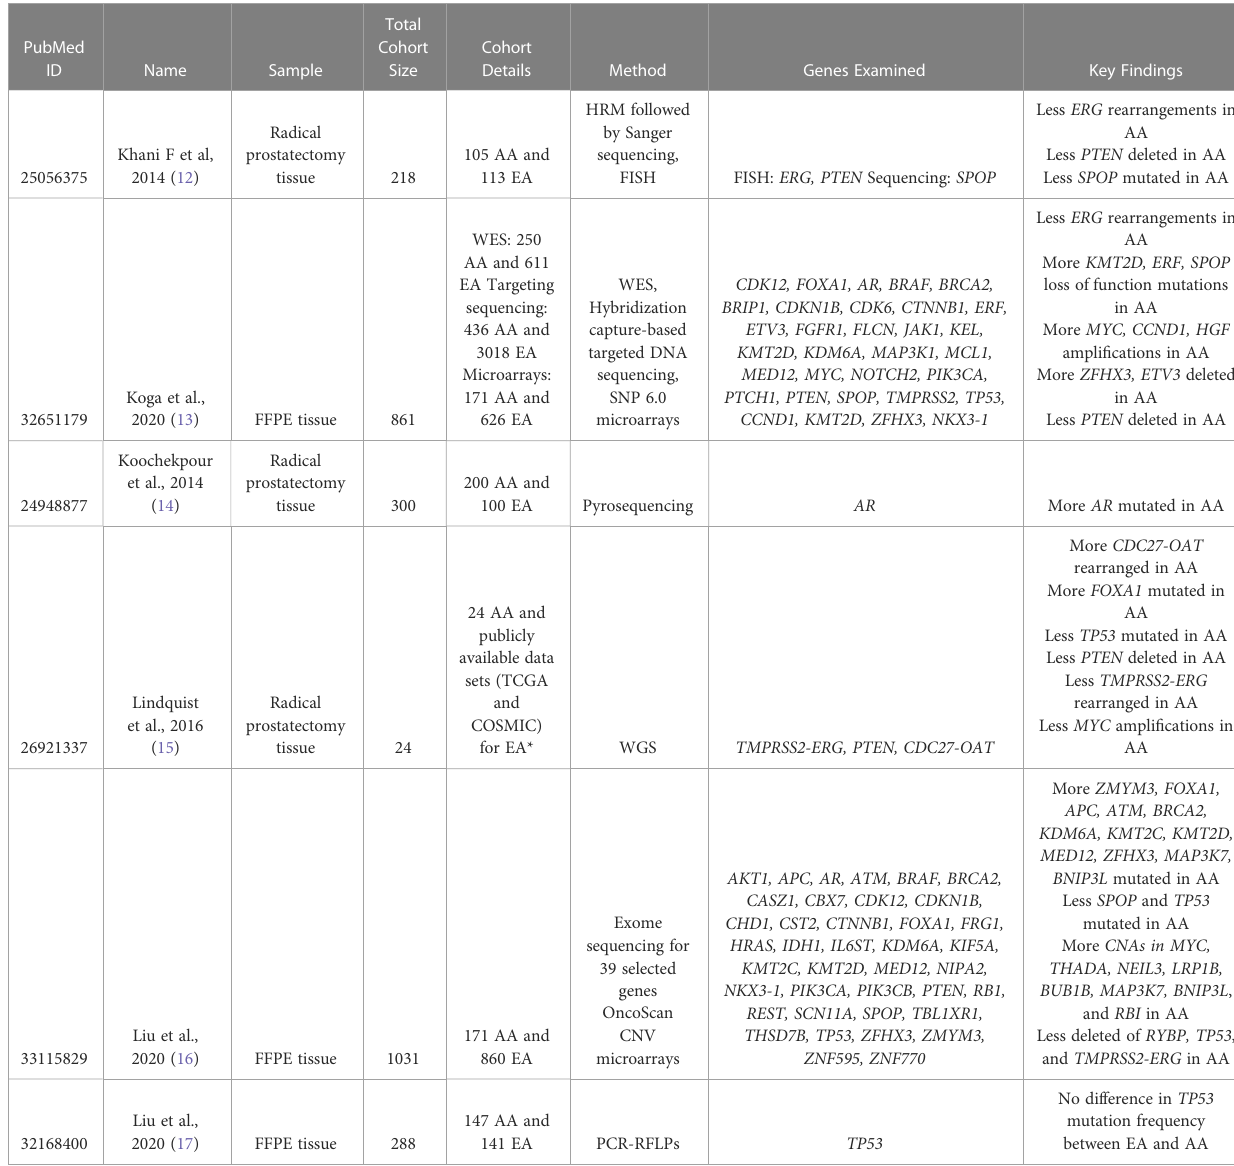
TABLE 1 Studies that compared genomic features between AA and EA patients.